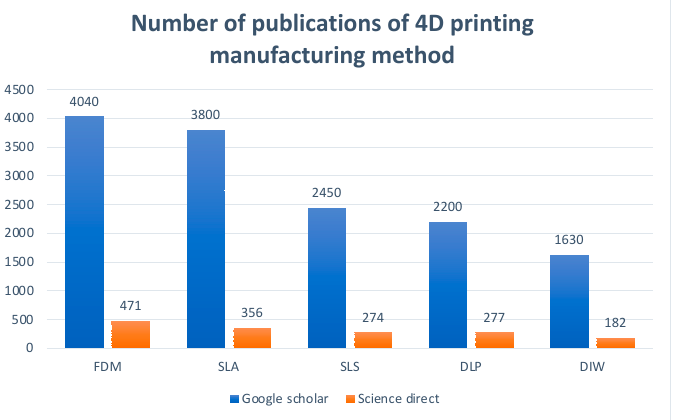
Figure 5. Number of publications for each 4D printing manufacturing method between 2013 and 2022 in Google Scholar and ScienceDirect databases (as of 30 November 2022).